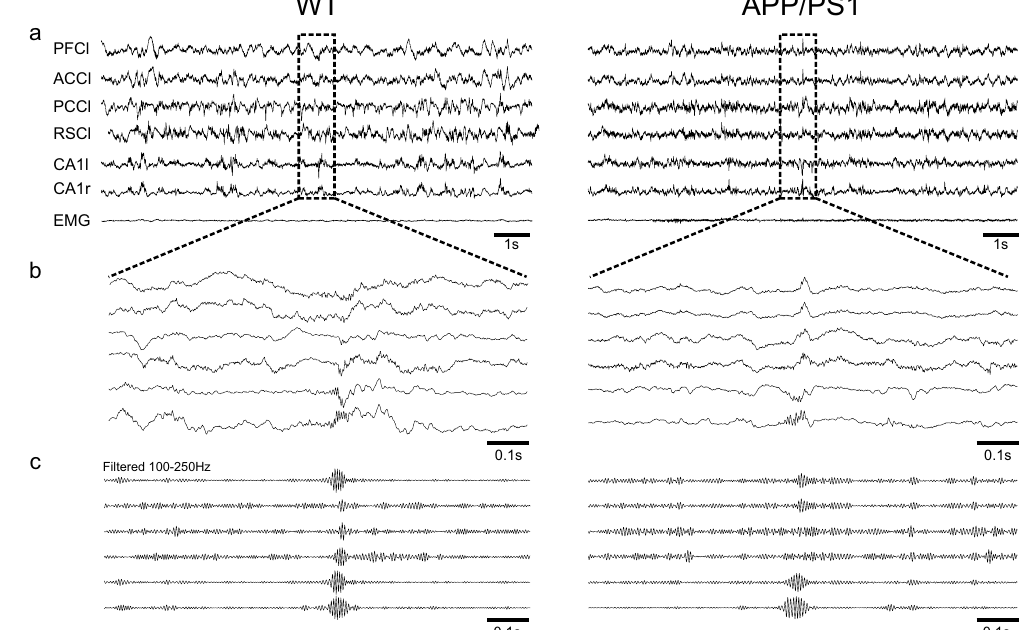
Figure 2. Representative example of co-occurring ripple-like oscillations generated in different cortical areas and hippocampal ripples in the wild-type and APP/PS1 animals. ( a) Simultaneous recordings of LFPs from prefrontal cortex left (PFC l ), anterior cingulate cortex left (ACC l ), post cingulate cortex left (PCC l ), retrosplenial cortex left (RSC l ), dorsal hippocampus CA1 left and right (CA1 l ), (CA1 r ) and electromyogram of the neck muscle (EMG) during slow wave sleep (SWS). ( b,c) Enlargement of 1 sec recordings of the LFPs showing co-occurring ripple oscillations in raw ( b ) and filtered ( c )